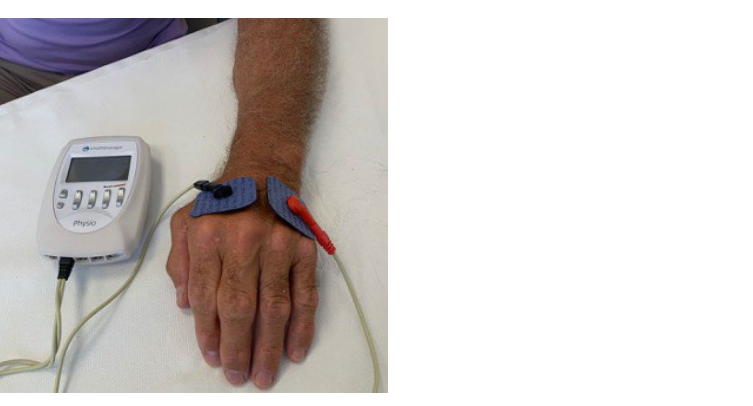
Figure 5. Illustration of a session of transcutaneous electrical nerve stimulation (TENS) performed within Path B rehabilitative protocol.